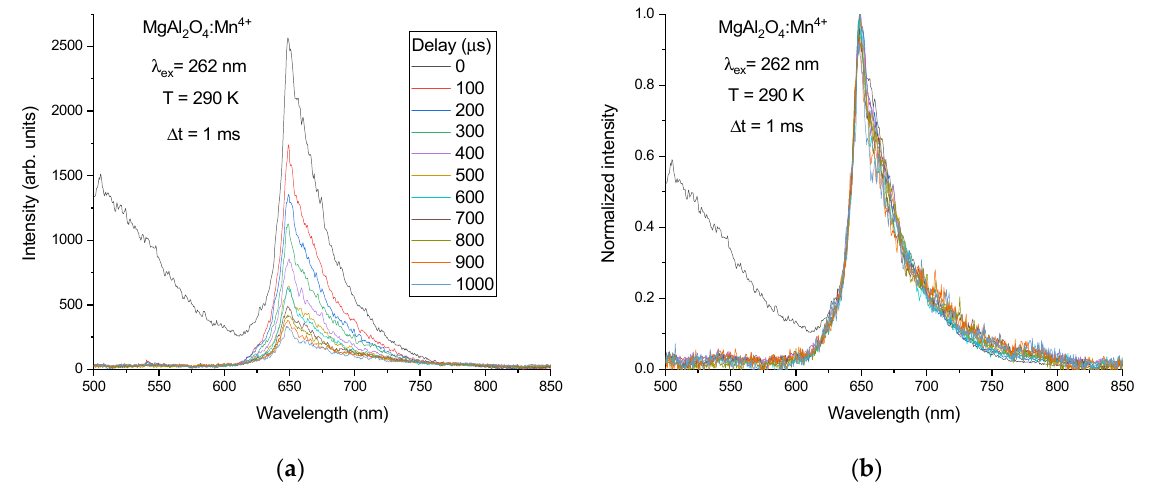
Figure 3. ( a ) Time-resolved PL spectra of the spinel MgAl 2 O 4 ceramics doped with 0.2 mol% MnO 2 (sample I) measured at 290 K with different delays (0–1 ms) between the laser pulse and the time gate ( ∆ t = 1 ms); ( b ) the same spectra normalized to the peak intensity.